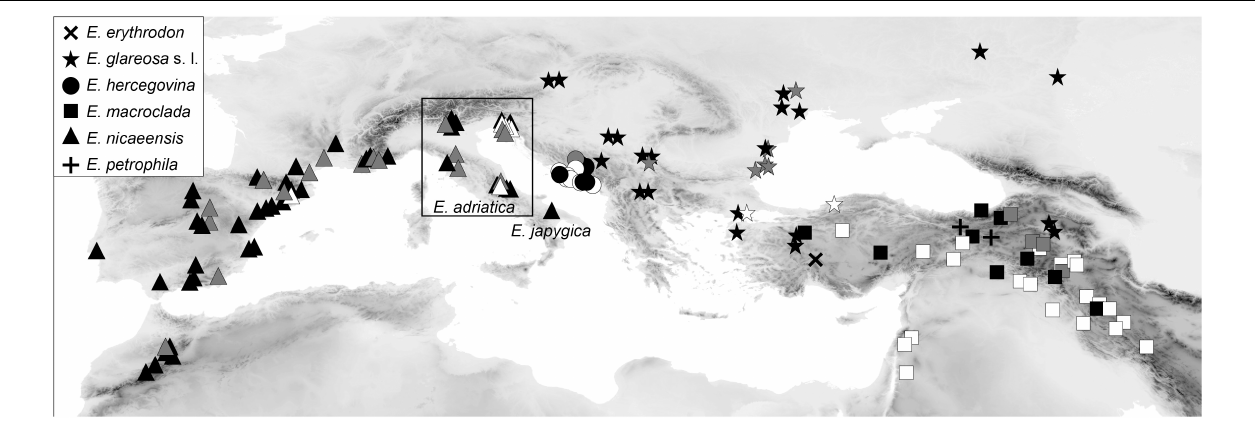
FIGURE 1 | Distribution of Euphorbia nicaeensis alliance populations sampled and used in this study. Black symbols indicate populations used in genetic (RADseq and/or ITS) and, mostly, also, in relative genome size (RGS) and morphometric analyses. Grey symbols indicate additional populations used in RGS and/or morphometric analyses; white symbols indicate populations used only in morphometric analyses. The corresponding population numbers are presented in Supplementary Figure 1 , and details are given in Supplementary Table 1 . Euphorbia adriatica and E. japygica have been previously included in E. nicaeensis but are, based on our results, independent